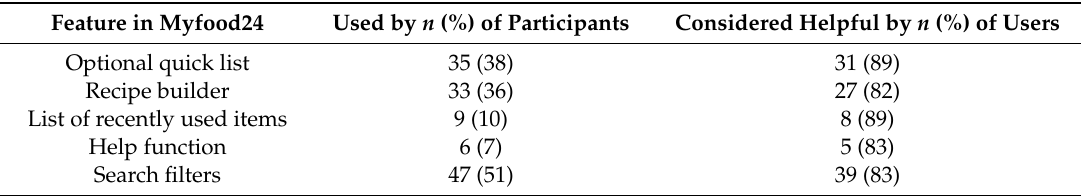
Table 3. Self-reported application and evaluation of available features in myfood24-Germany by participants completing an evaluation questionnaire ( n = 92).